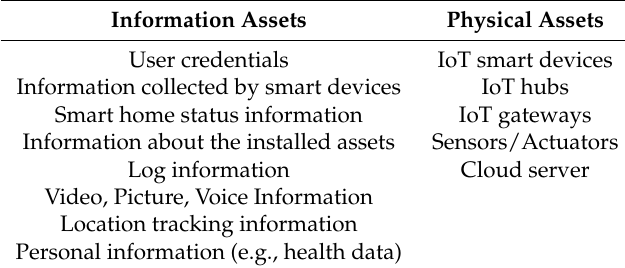
Table 1. Identified assets